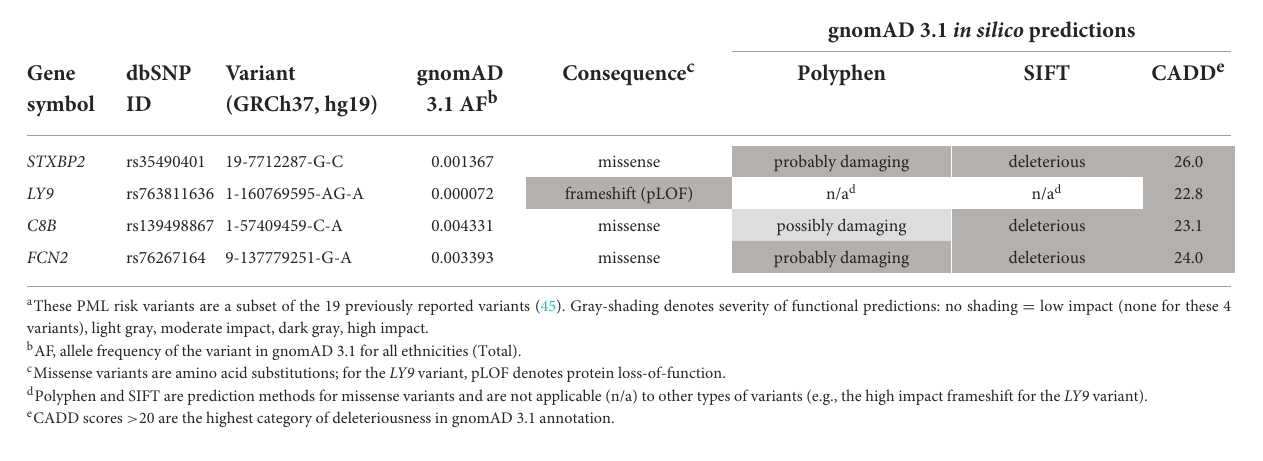
TABLE 3 PML risk variant functional impact predictions.